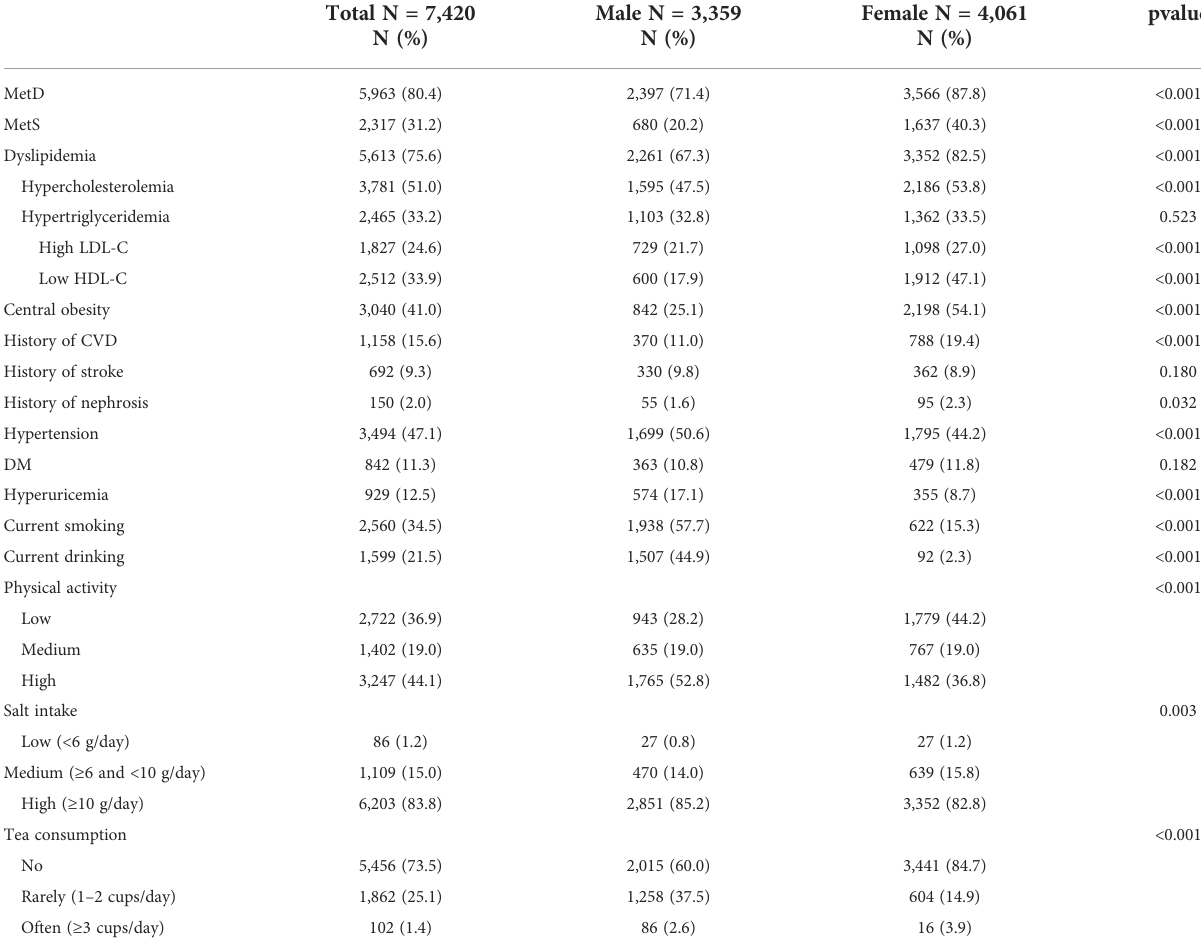
TABLE 1 Risk factor characteristics of the baseline